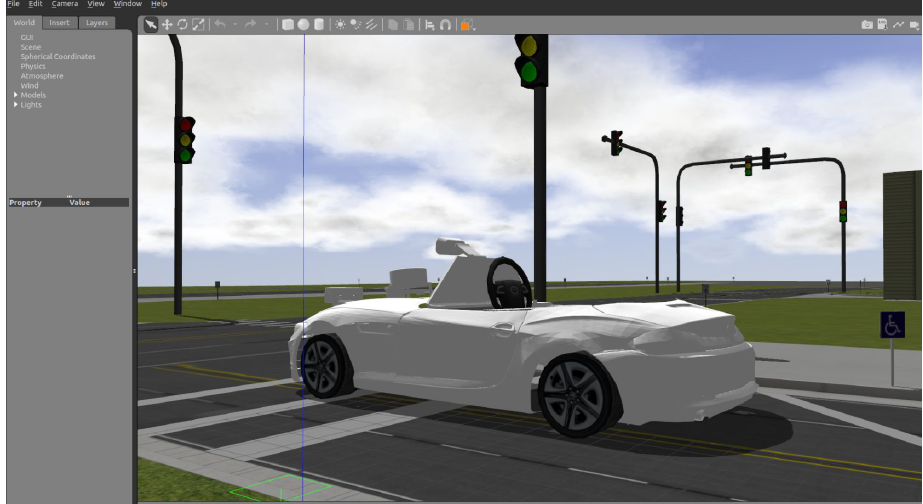
Figure 15. A URDF model of the vehicle. The car model is deployed into a 3D simulated